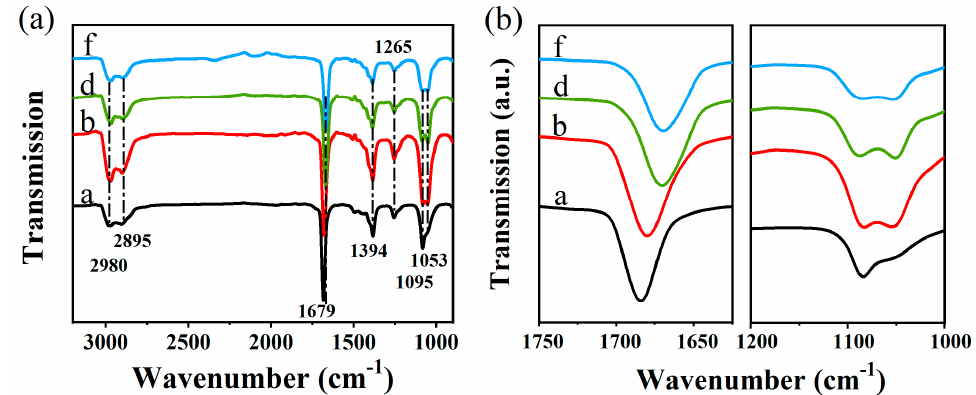
Figure 5. ( a ) Fourier transform infrared (FTIR) spectra of samples a, b, d, f; ( b ) Highly magnified FTIR spectra of samples a, b, d, f ranging from 1750 to 1625 cm − 1 and 1200 to 1000 cm − 1